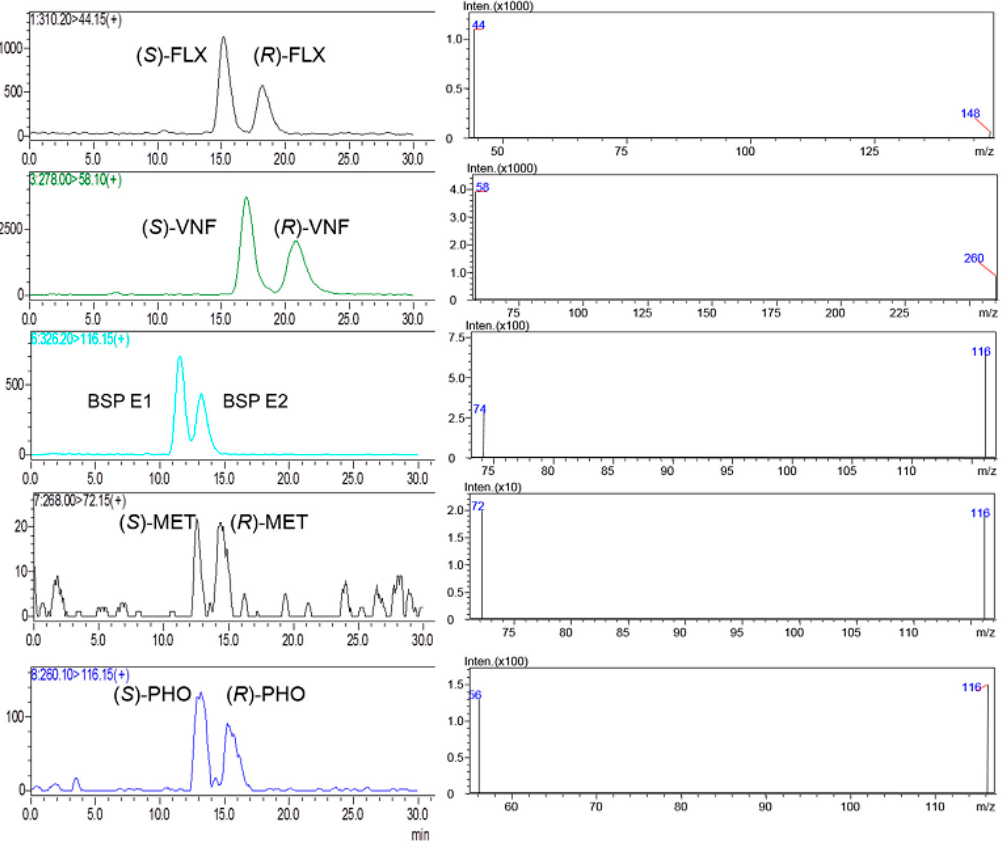
Figure 5. Chromatogram and mass spectra of WWTP effluent sample showing the enantiomers of FLX, VNF, BSP, MET and PHO. Reproduction with permission of Elsevier (Figure 2 from Ribeiro et al. [39]).